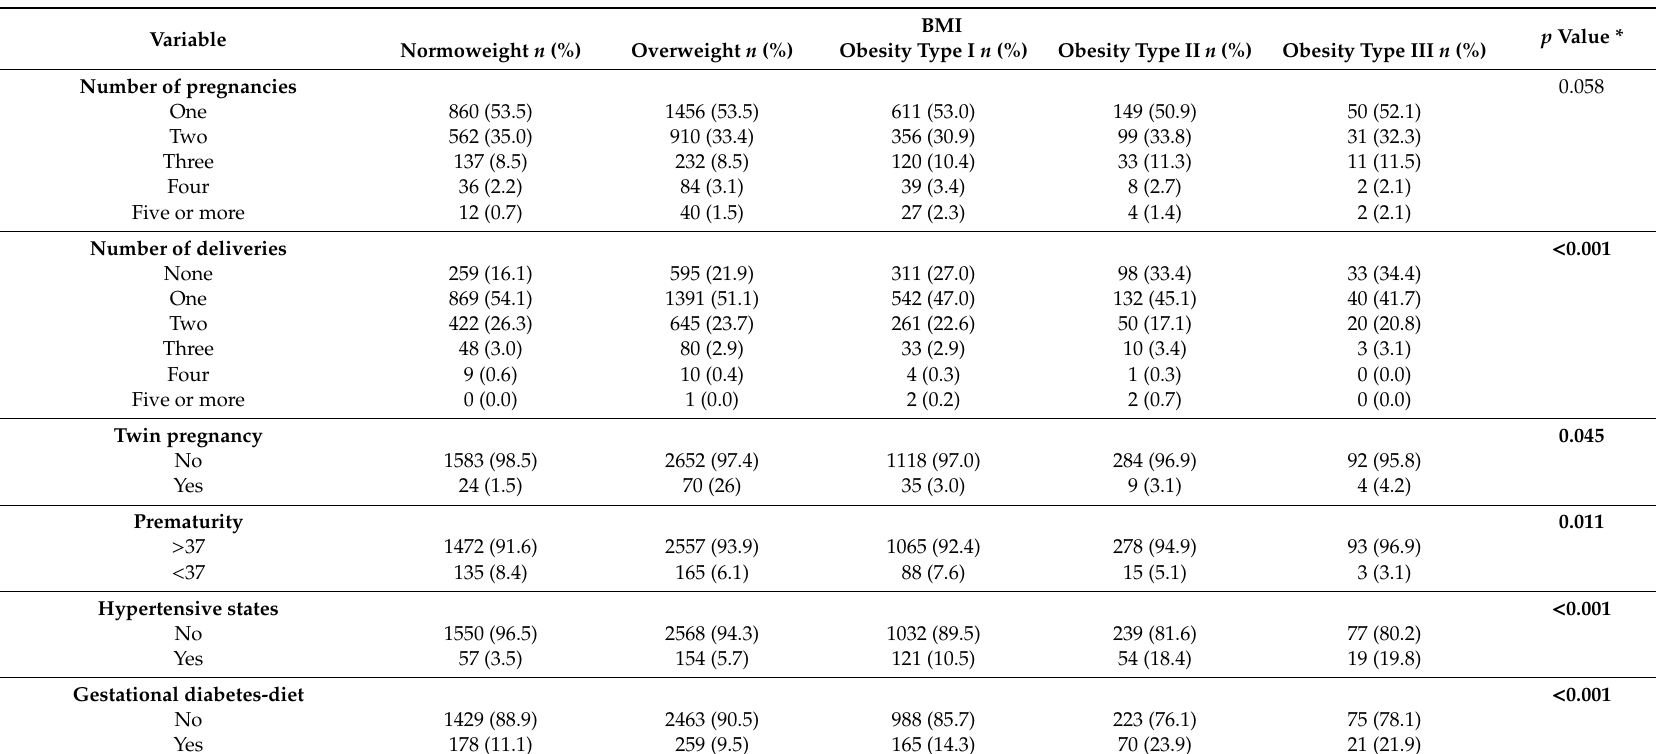
Table 2. Obstetric characteristics of the women according to the